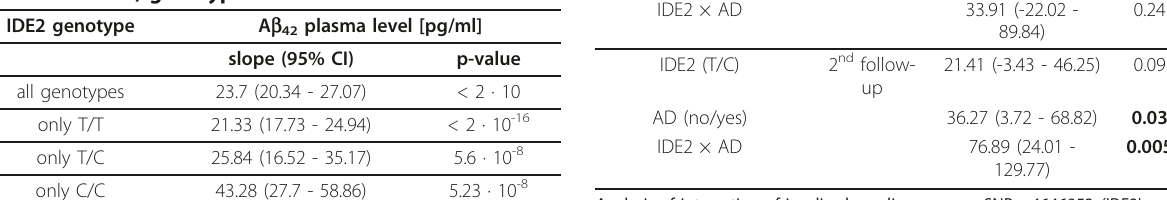
Table 3 Longitudinal analysis of amyloid b 42 (A b 42 ) plasma levels in different insulin degrading enzyme 2 (SNP rs4646953) genotypes